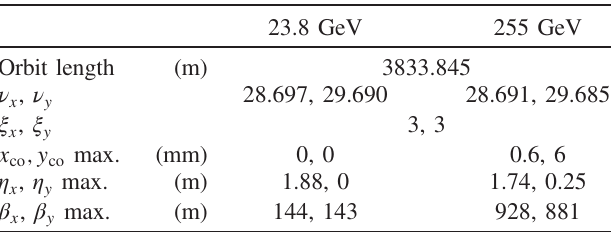
TABLE III. RHIC Yellow lattice without snakes, Run 22 reference parameters, at injection and store energies. The orbit is taken flat at injection and featuring vertical separation bumps (up to 6 mm) at IPs, at 255 GeV.